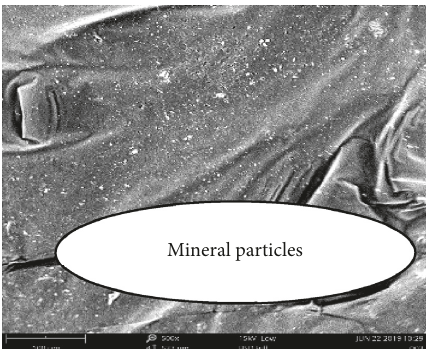
Figure 10: 10% of Buton-modified asphalt.